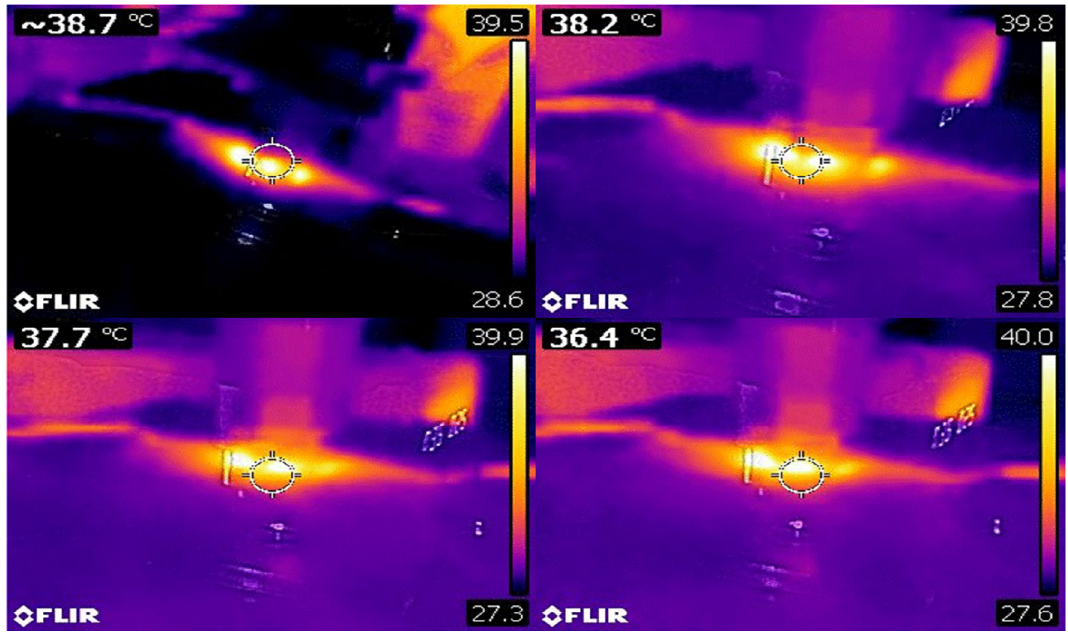
Figure 7. Illustrate the temperature of the cultured cells under the effect of plasmonic taken by an IR